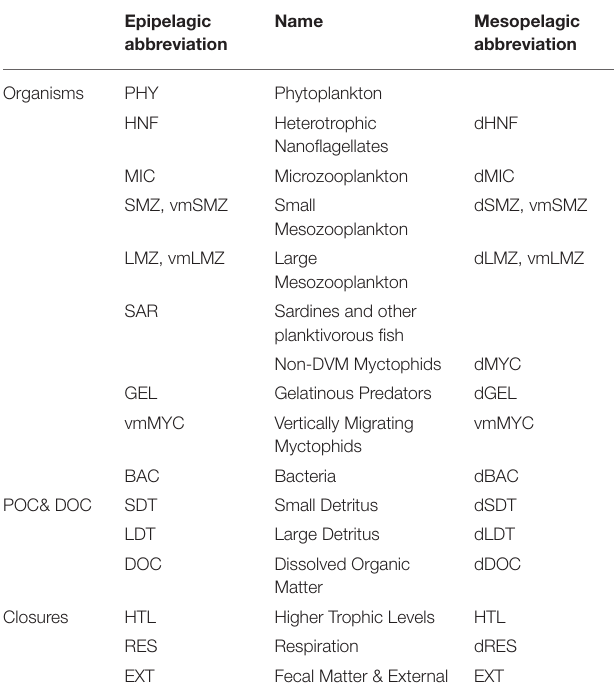
TABLE 2 | Names and abbreviations of all model